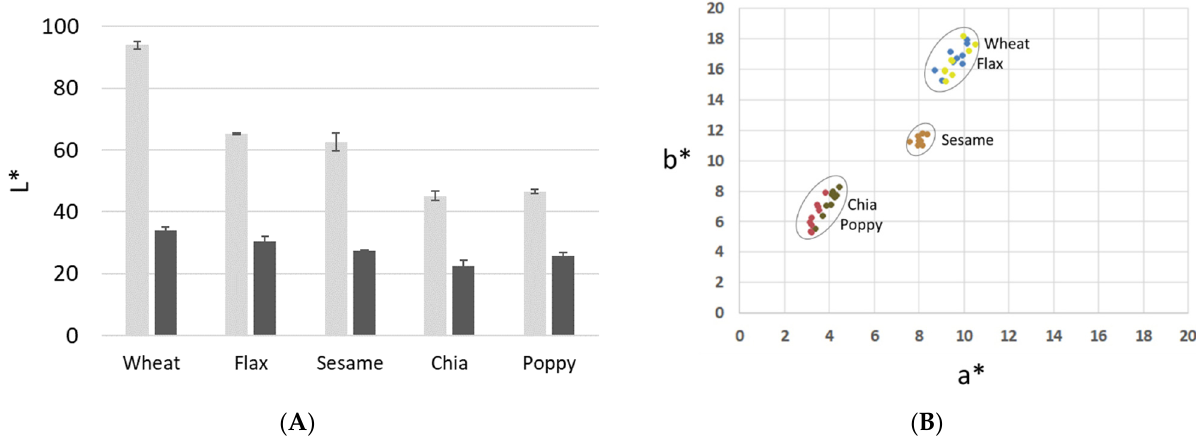
Figure 1. ( A ) Values of brightness (L*) of flour (light grey bars) and cookies (dark grey bars). ( B ) Values of CIELab color coordinates a* (red-green) and b* (yellow-blue) of the cookies elaborated with the different defatted seed flours.